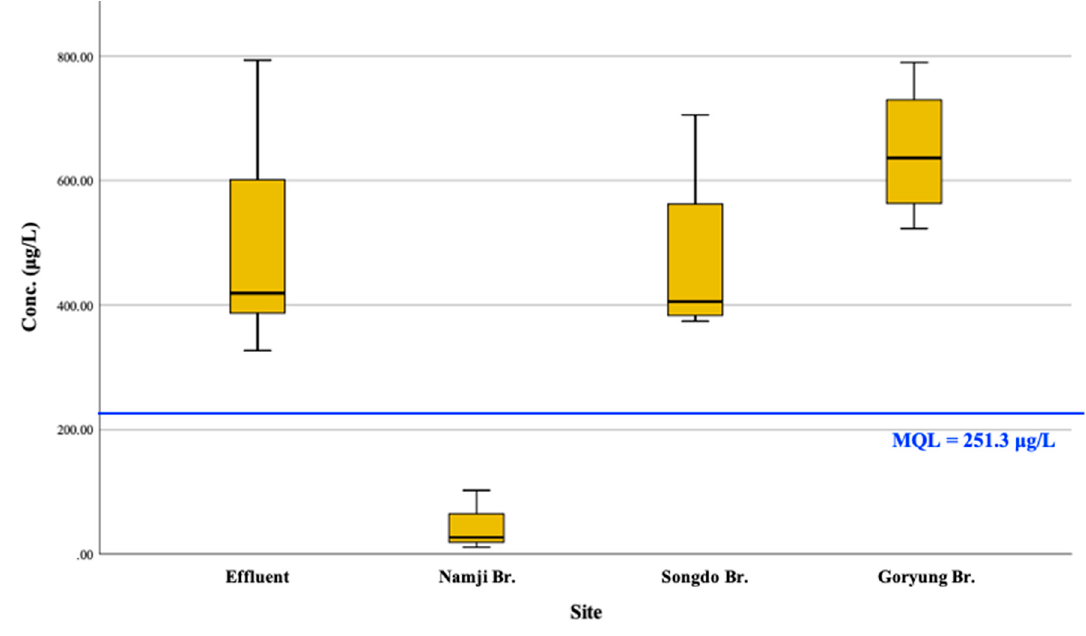
Figure 4. Detection range of methanol confirmed by online monitoring of headspace–SIFT-MS on actual samples at wastewater treatment plant and river.